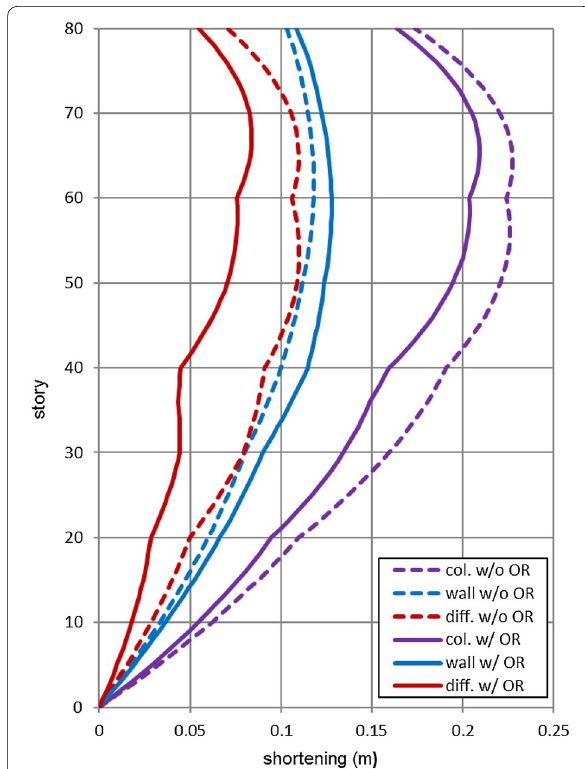
Fig. 2 Shortening of the general model without and with an outrigger placed at the 40‑th